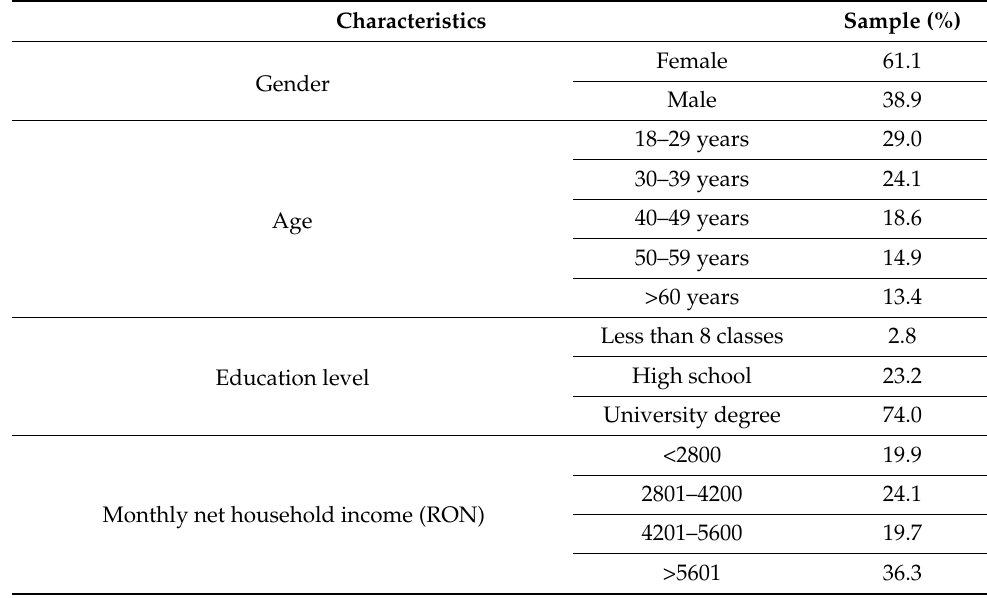
Table 2. Respondents socio-demographic